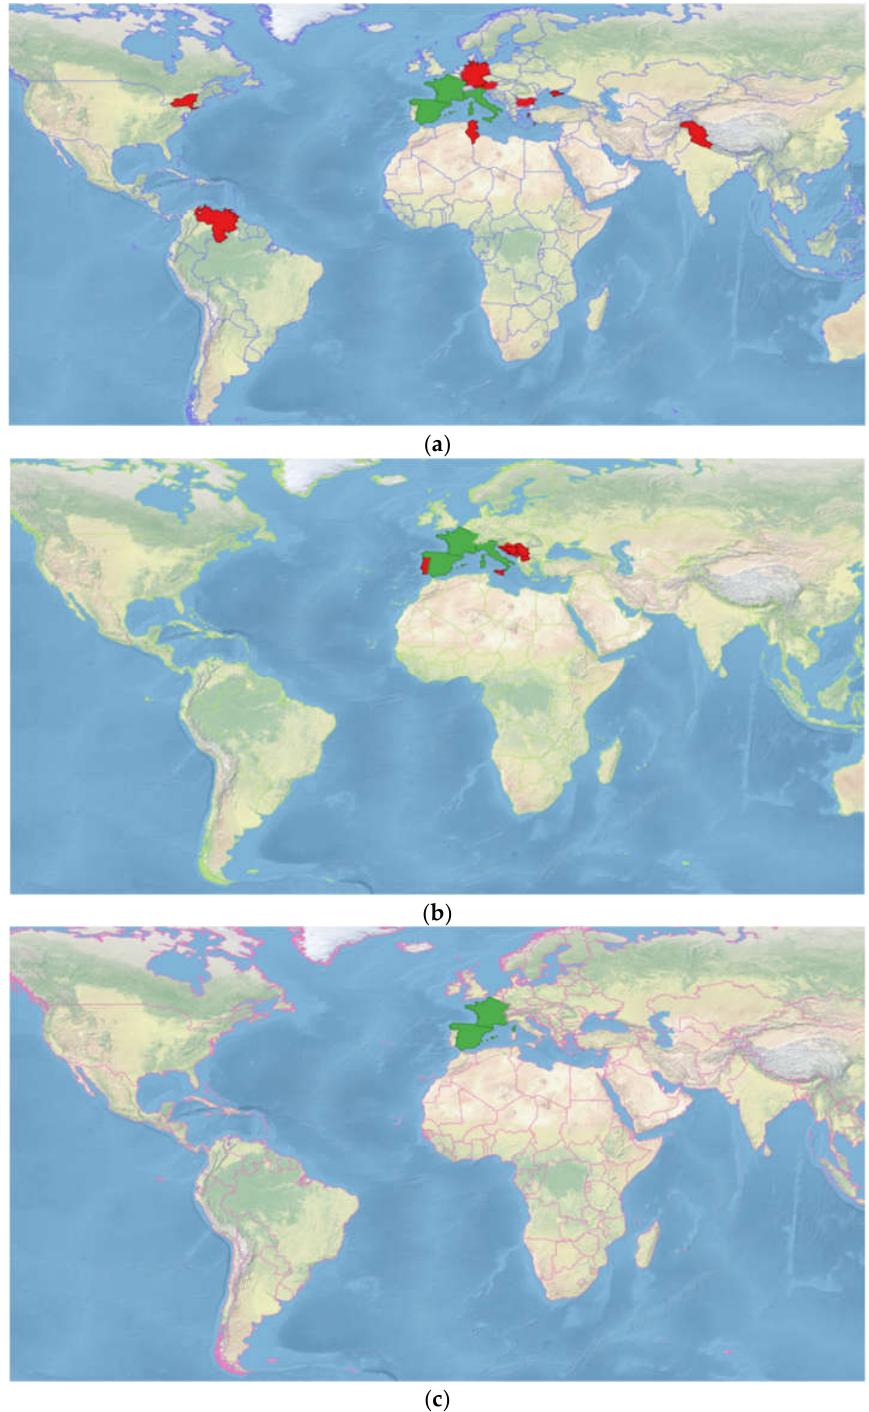
Figure 1. The distribution of ( a ) Lavandula angustifolia , ( b ) Lavandula latifolia , ( c ) Lavandula × intermedia according to Plants of the World Online , published by the Royal Botanic Gardens (Kew). The green color represents the native range of distribution and the red color represents the secondary range of distribution. Map source: Made with Natural Earth, https://www.naturalearthdata.com/downloads/50m-natural-earth-1/50m-natural-earth-i-with-shaded-relief-and-water/ (accessed on 2 January